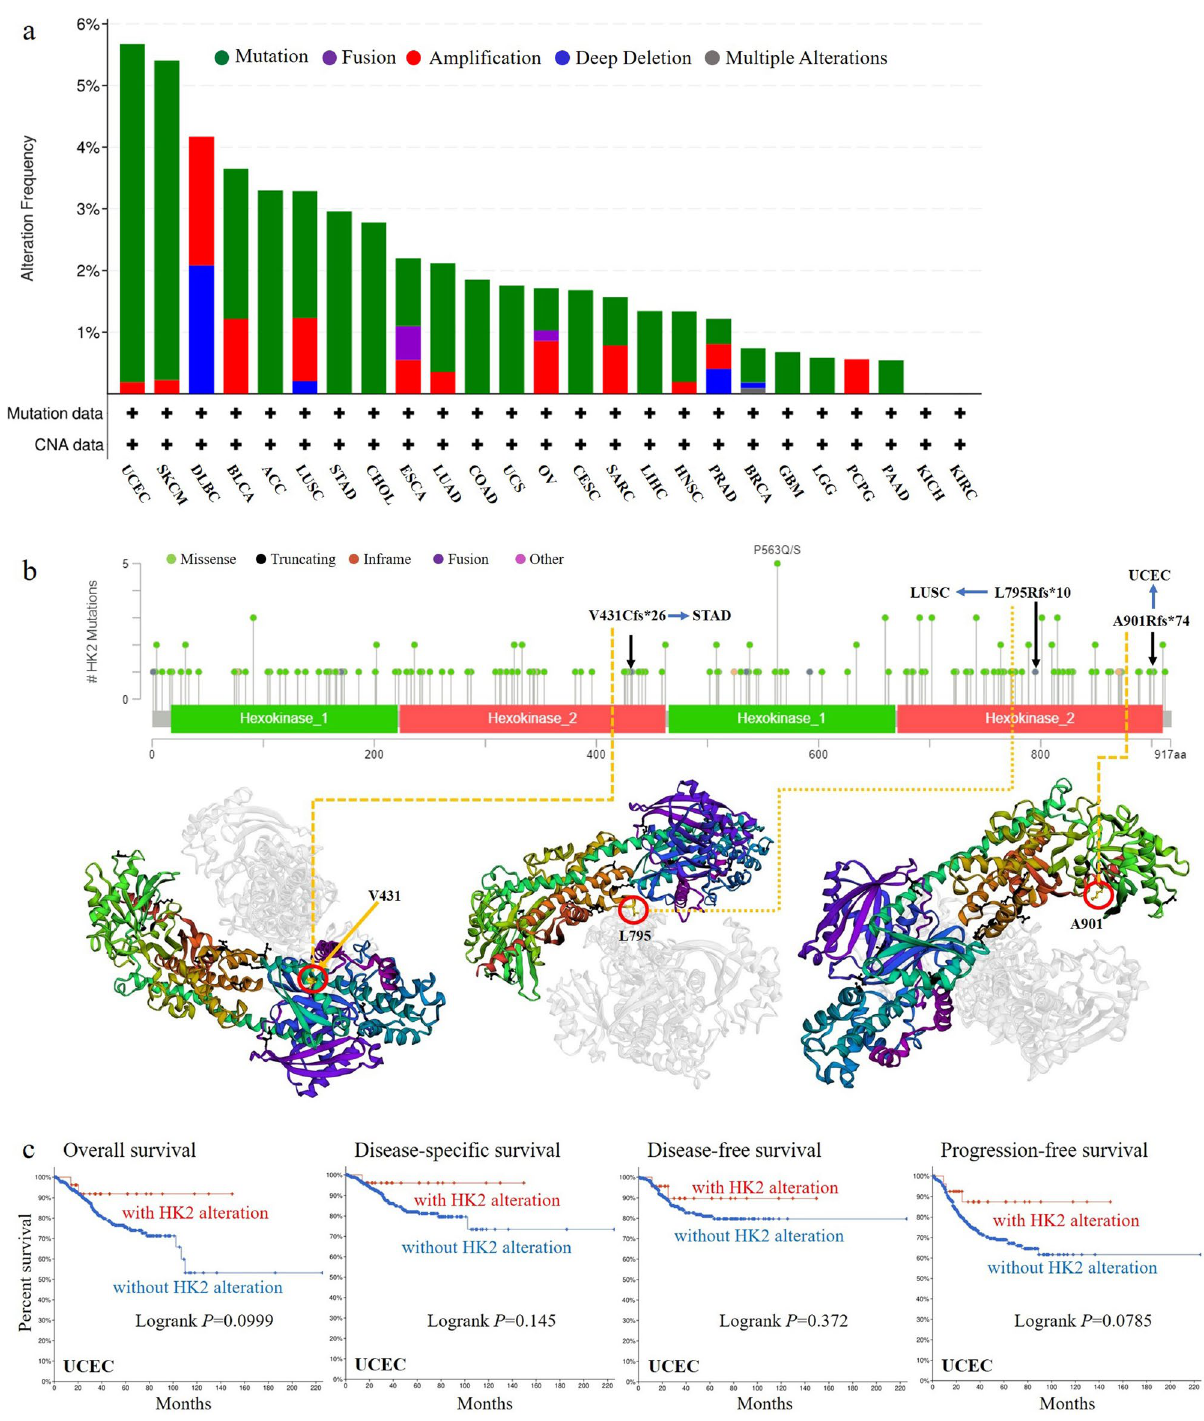
Figure 3. Mutation feature of HK2 in different tumors of TCGA. The mutation features of HK2 for the TCGA tumors were analyzed using the cBioPortal tool. The alteration frequency with mutation type ( a ) and mutation site ( b ) are displayed. The mutation site (V431Cfs*26, L795Rfs*10, and A901Rfs*74) in the 3D structure of HK2 were also displayed ( b ). The potential correlation between mutation status and overall, disease-specific, disease- free, and progression-free survival of UCEC ( c ) was also analyzed using the cBioPortal